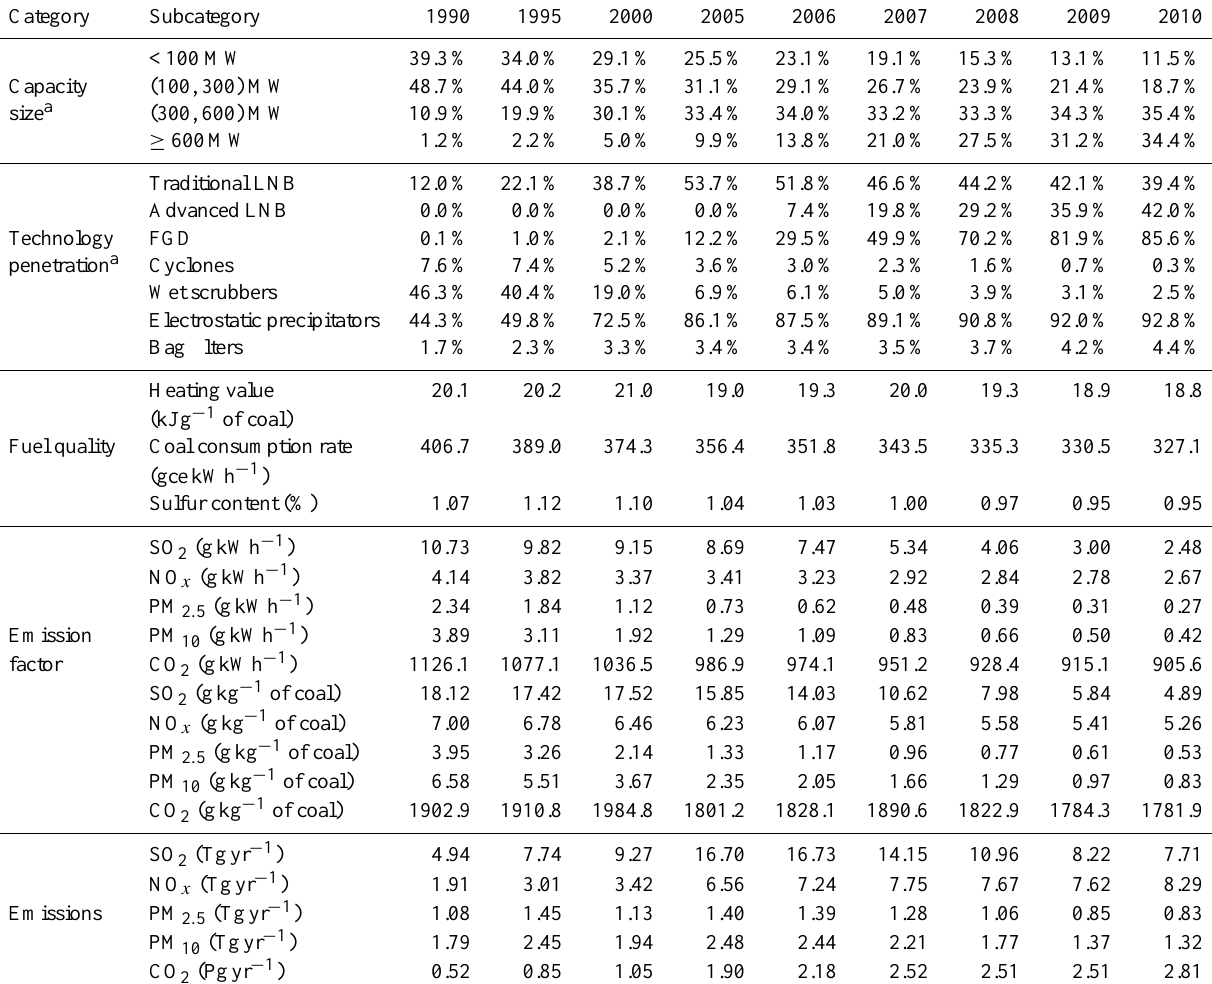
Table 4. Capacity sizes, technology penetrations, fuel qualities, emission factors, and emissions of coal-fired power plants in China from 1990 to